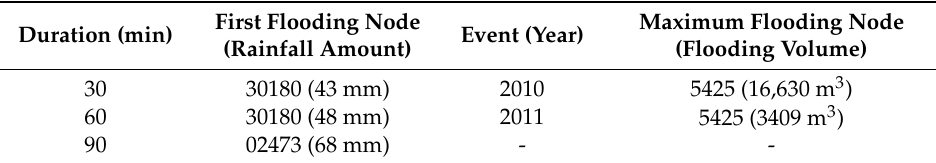
Table 4. Results of monitoring node selection.